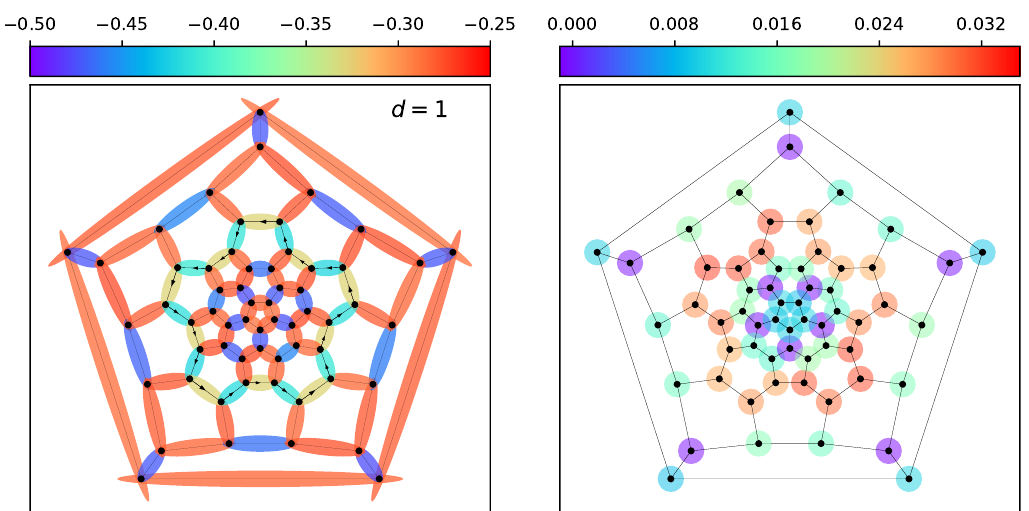
〉 d = 1 〉 in the same i